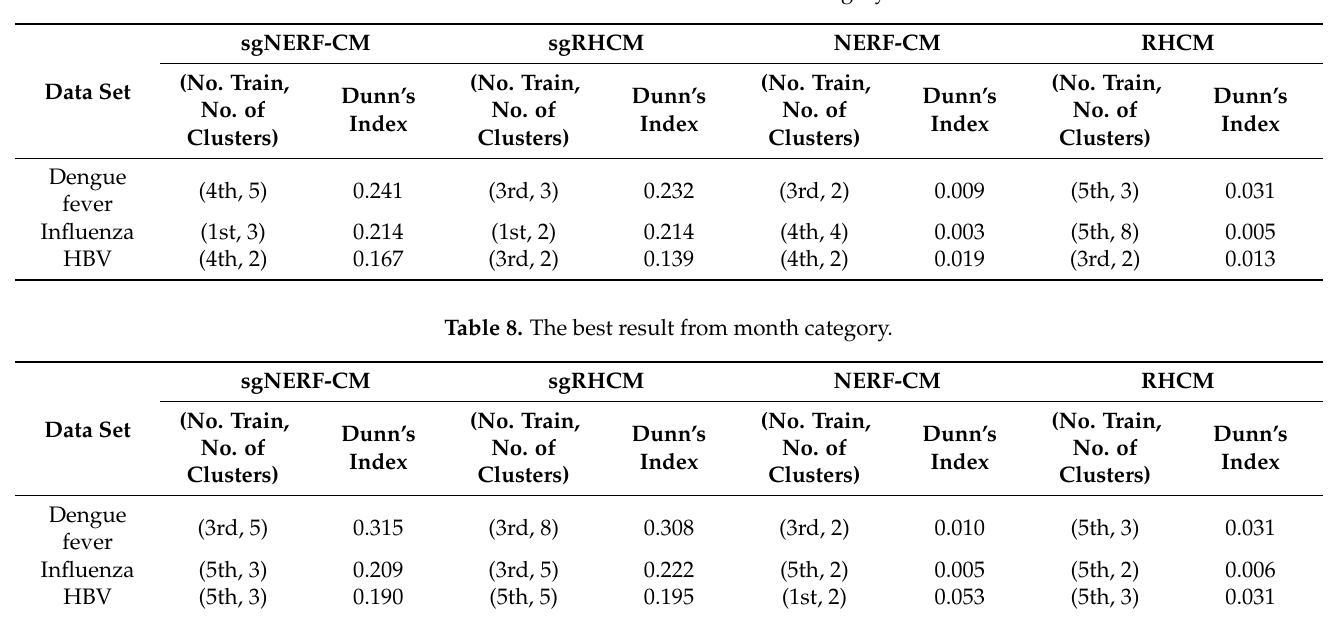
Table 7. The best result from career category.